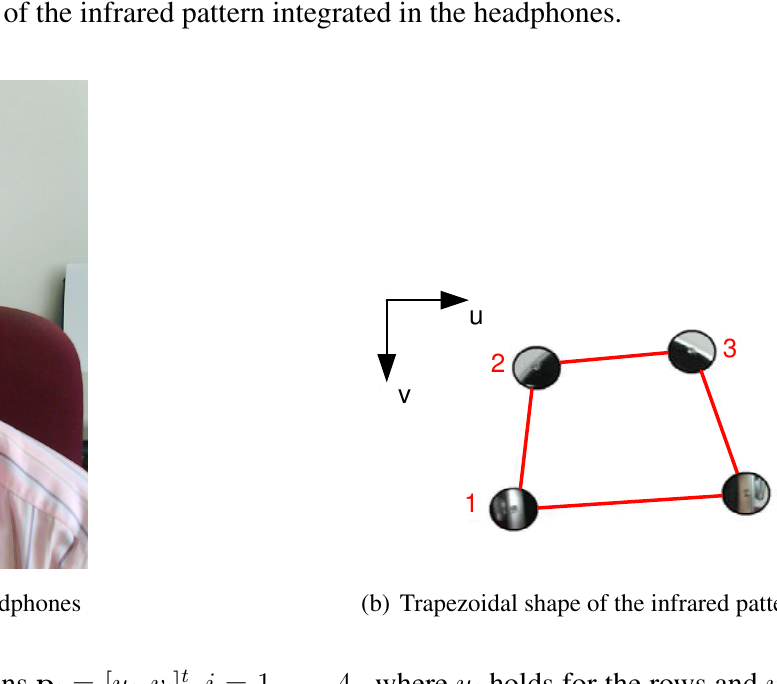
Figure 5. Shape of the infrared pattern integrated in the